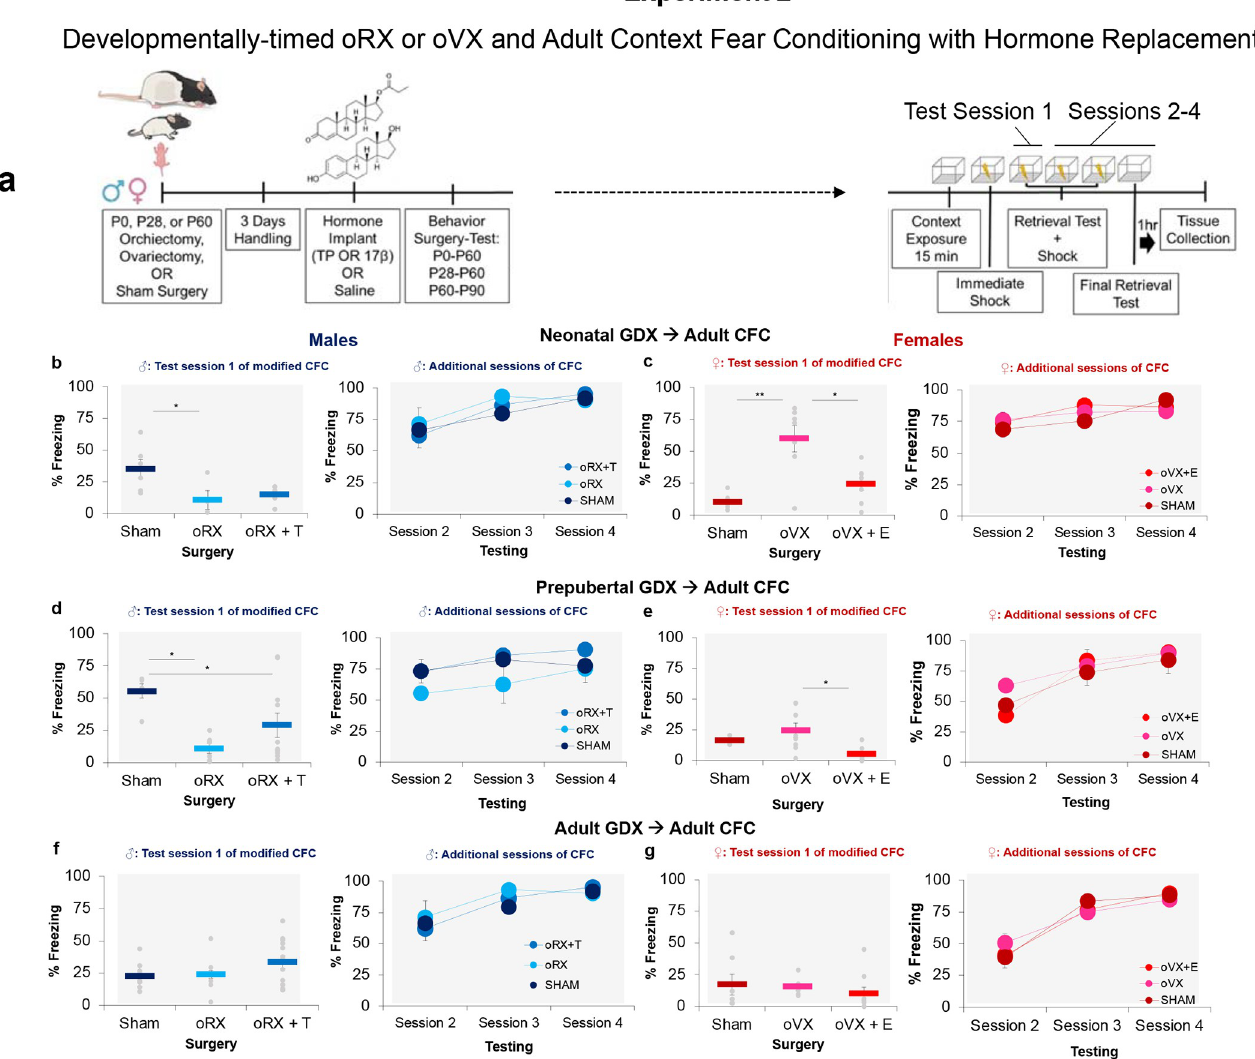
Fig 2. Sex-specific effects of gonadal removal during development upon CFC. Experimental timeline to examine the effects of orchiectomy or ovariectomy at birth, prior to puberty or adulthood and with or without prior hormone treatment upon adult CFC ( a ). ( b ) Neonatal oRX reduced adult CFC on test session 1 in comparison to sham males ( � p < .05) ( n = 4-6/group). ( c ) Neonatal oVX enhanced adult CFC on test session 1 in comparison to sham ( �� p < .01) and oVX + E females ( n = 7-8/group). ( d ) Prepubertal oRX and oRX + T reduced adult CFC on test session 1 in comparison to sham males ( � p < .05) ( n = 5-11/ group). ( e ) Prepubertal oVX plus adult estrogen implantation reduced CFC on test sessions 1 and 2 ( n = 5-8/group). ( f ) Adult oRX produced no significant effects ( n = 5-14/group). ( g ) Adult oVX produced no significant effects ( n =